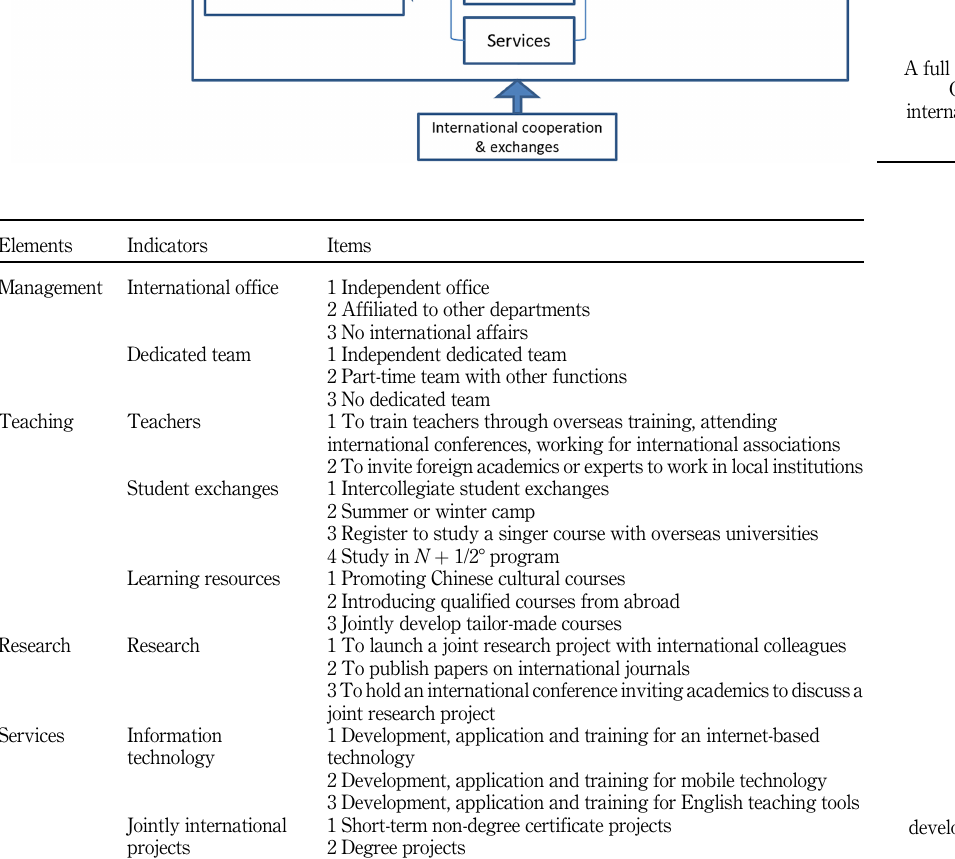
Figure1. A full picture of the OUC system ’ s internationalization